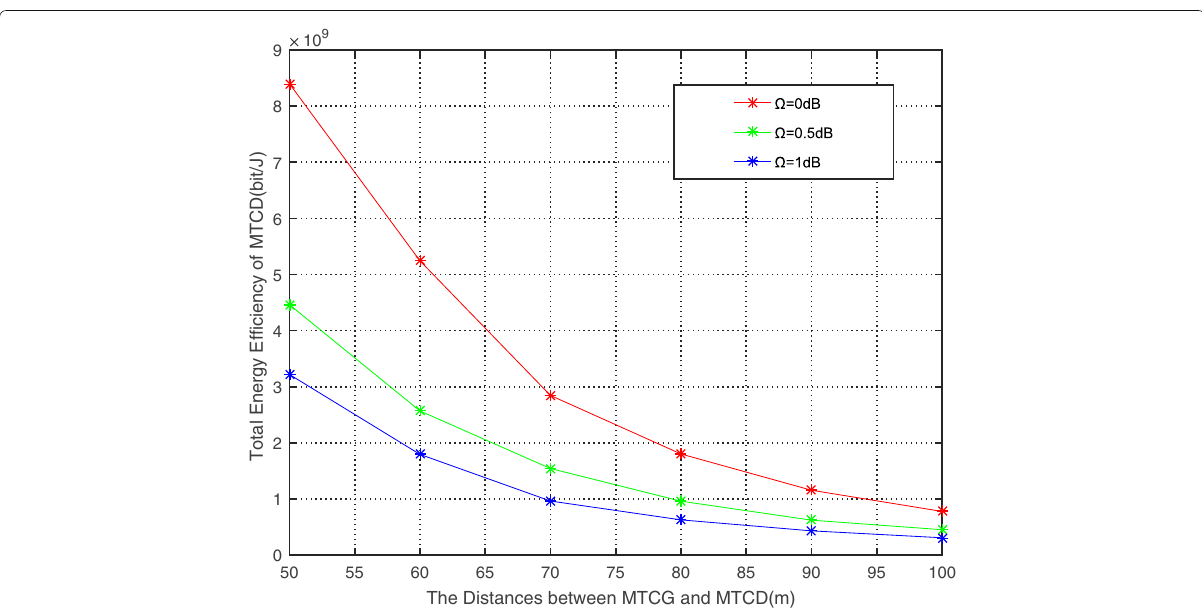
Fig. 7 The total energy efficiency with varying MTCD-to-MTCG distances. The payload of each MTCD is 1000 bit/TTI, the MTCG’s bandwidth is 20 × 180 kbit, and the number of groups of MTCDs is K = 10